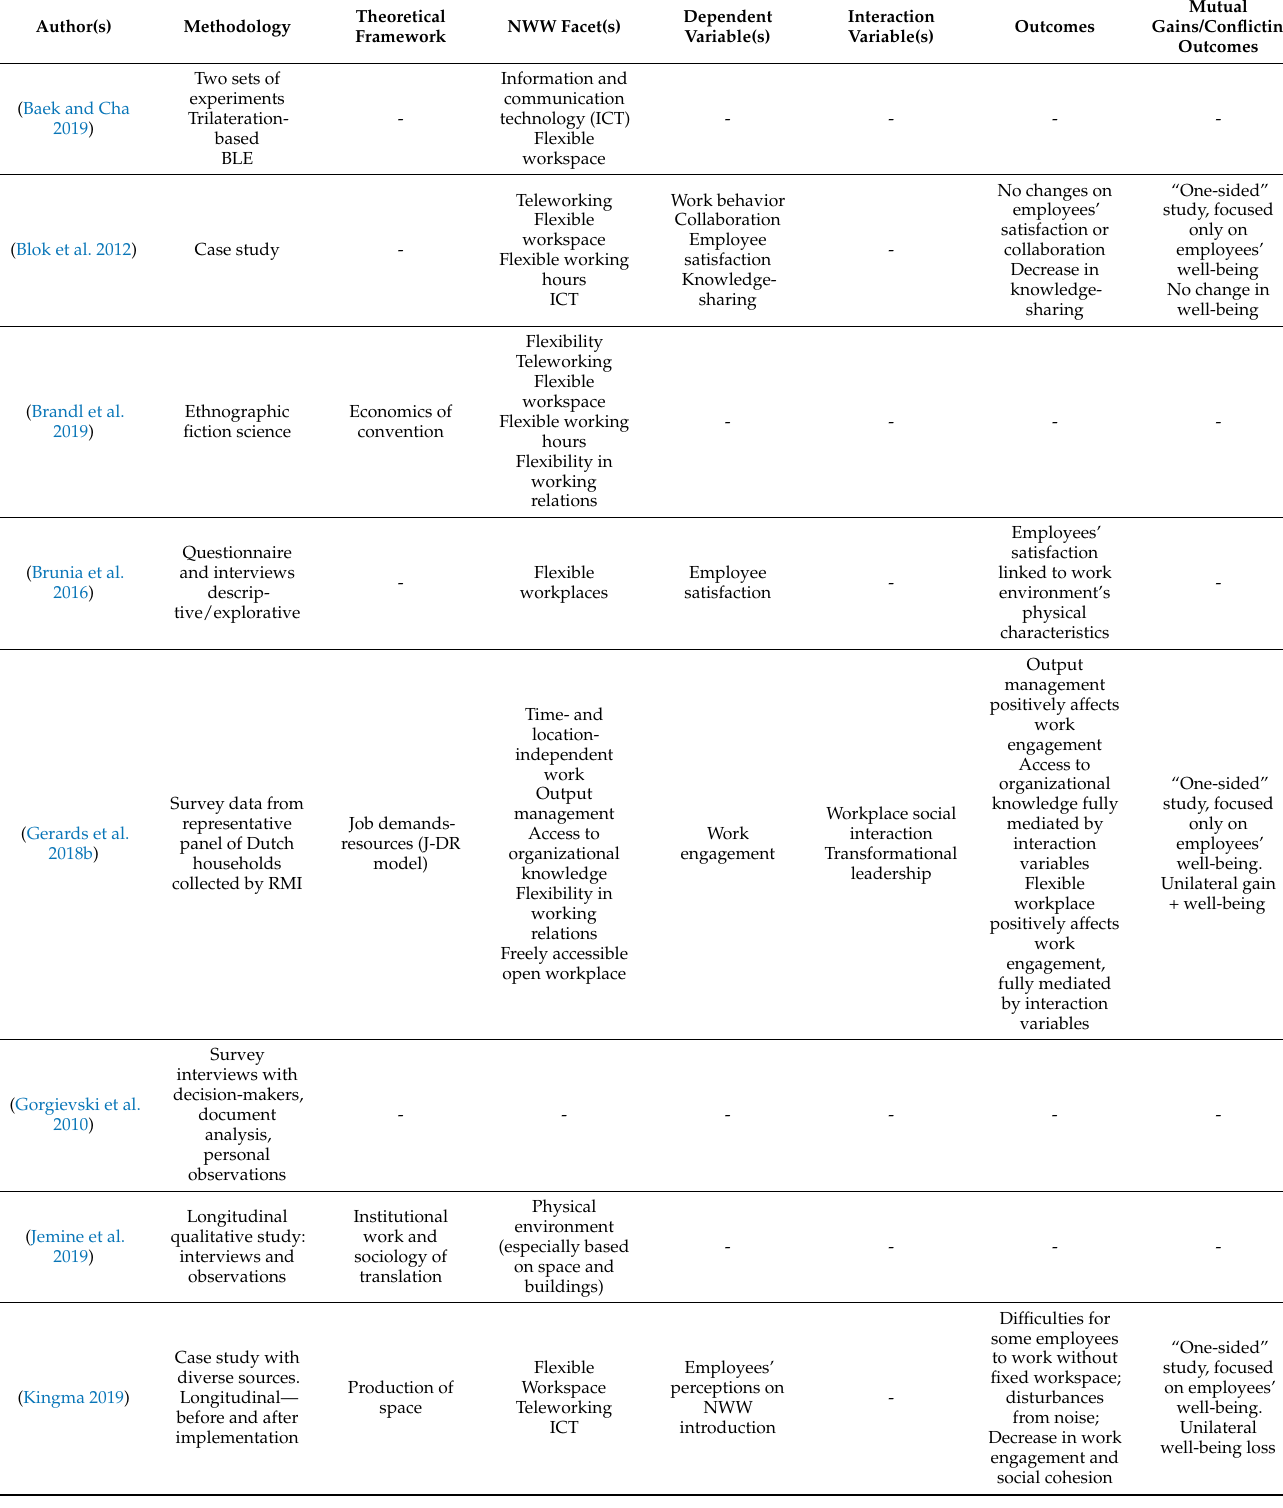
Table 1. Variables in new ways of working (NWW)